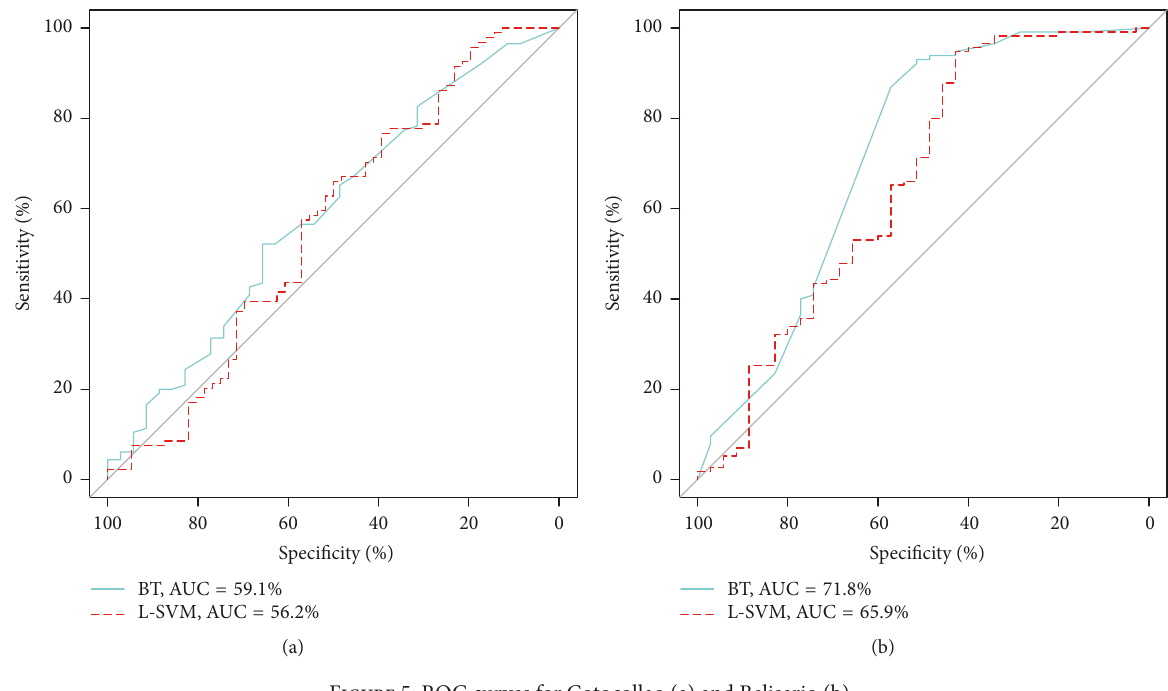
Figure 5: ROC curves for Cotocollao (a) and Belisario (b).